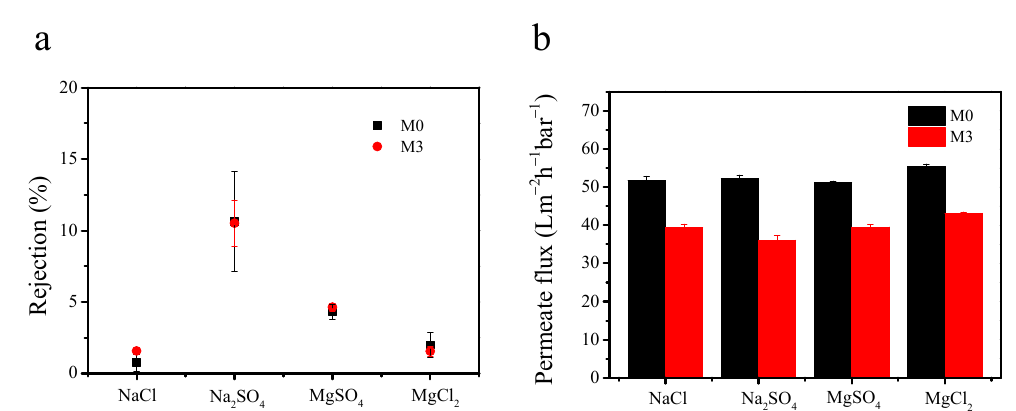
Figure 12. Salts separation performance: rejection measured for different salt solutions (1000 mg/L) ( a ); permeation flux of salt solution ( b ); (pressure of 1 bar was applied).